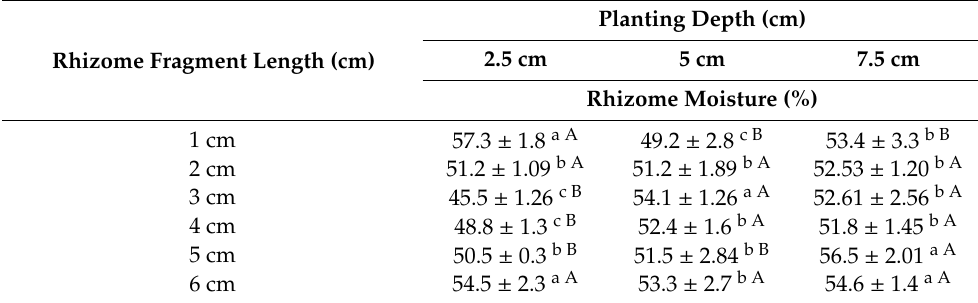
Table 4. E ff ect of planting depth and fragment length on the rhizome moisture content of A. amatymbica .